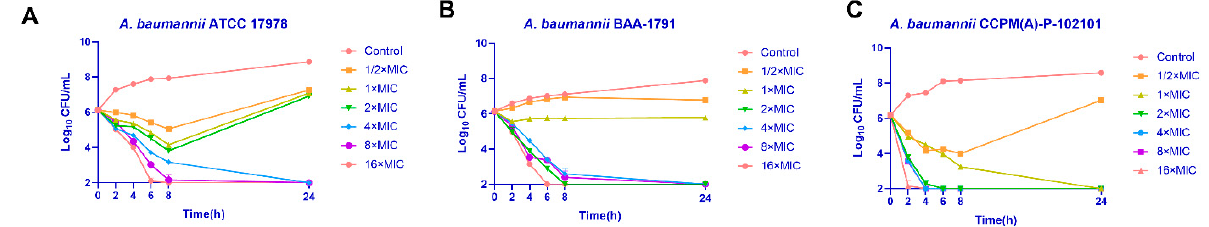
Figure 4. Time-killing curves of OYYF-171 against A. baumannii isolates.